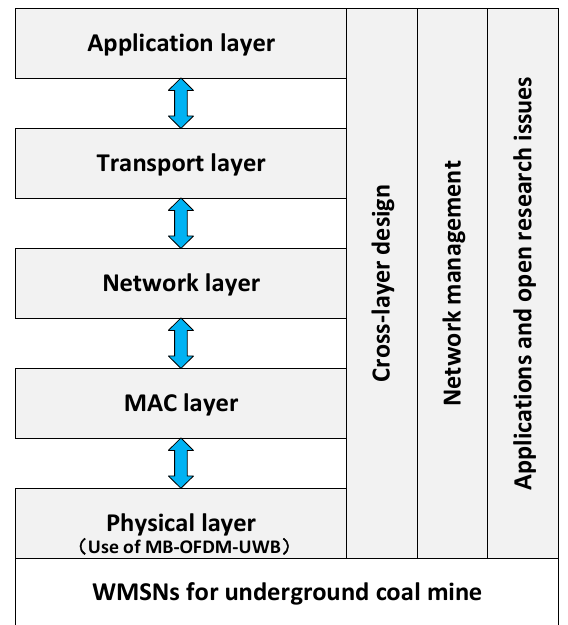
Figure 4. Main research issues for underground coalmine WMSNs.